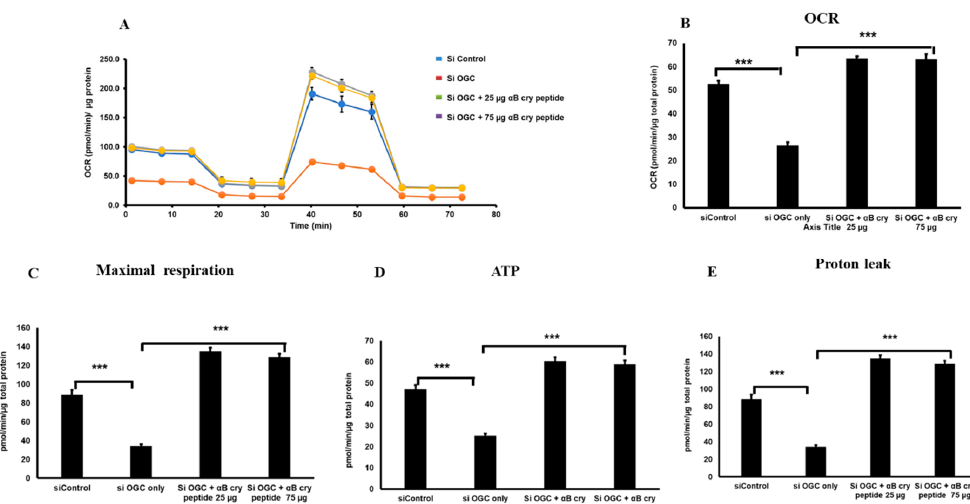
Figure 6. OGC knockdown in RPE caused a decline in mitochondrial oxygen consumption and ATP production. Mitochondrial bioenergetics analyses of RPE cells were made with or without OGC silencing and effect of α B cry peptide treatment was determined ( A – E ). SiRNA mediated OGC silencing caused a significant decrease in mitochondrial respiration, proton leak, and ATP production. Treatment of OGC silenced cells with α B cry peptide for 24 h enhanced mitochondrial respiration and associated parameters when compared to silenced controls. Data are mean ± SEM. n = 10; *** p <